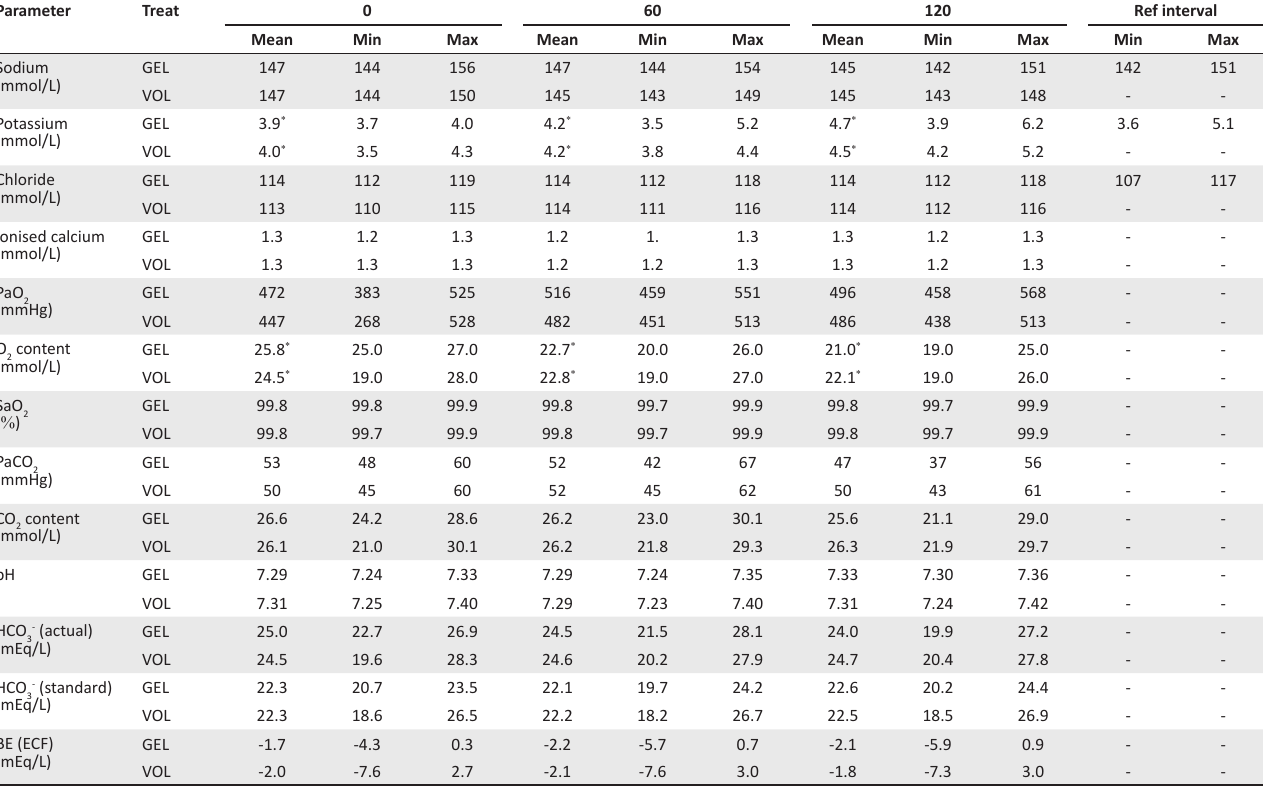
TABLE 2: Measured and calculated blood gas, electrolyte and pH variables of eight healthy beagle dogs undergoing colloid fluid infusion for 120 min with 10 mL/kg/h of Gelofusine ® (succinylated gelatin) or Voluven ® (tetrastarch 130/0.4). Parameter Treat 0 Sodium (mmol/L) Potassium